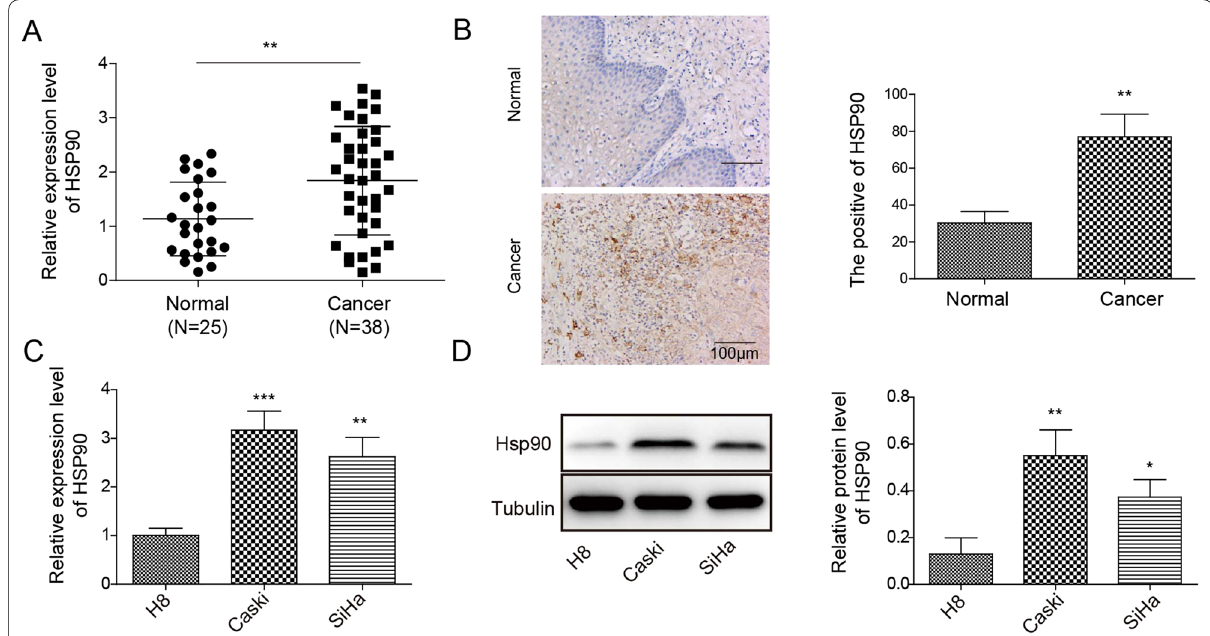
Fig. 1 The Hsp90 expression was increased in HPV16 + cervical cancer. A Hsp90 gene expression in normal and cancer tissues. B IHC staining of Hsp90 in normal and caner tissues. C Hsp90 gene expression in normal (H8) and cancer (Caski and SiHa) cervical epithelial cell lines. D Western blot of Hsp90 expression in normal (H8) and cancer (Caski and SiHa) cervical epithelial cell lines. Clinical samples: N of cancer tissue group. ** p < 0.01. Cell culture study: N